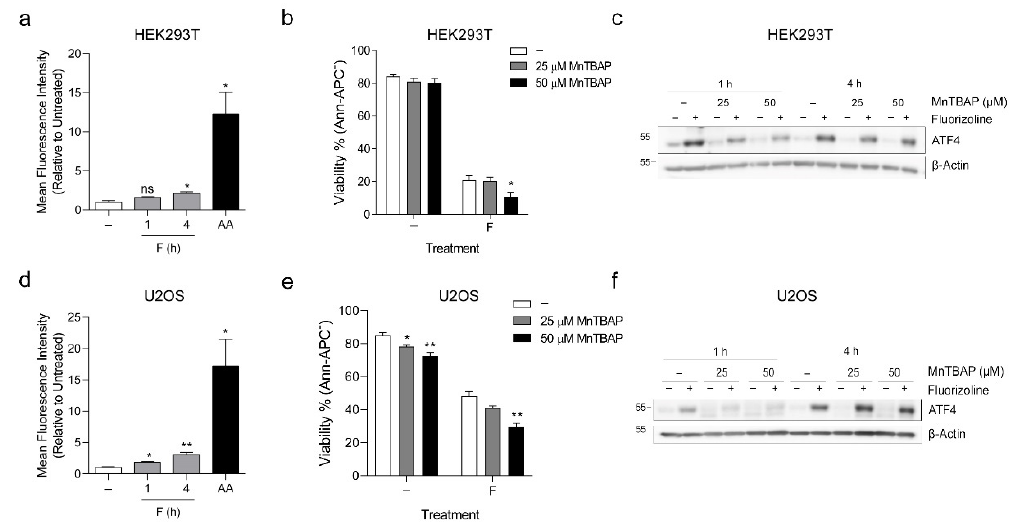
Figure 4. Fluorizoline causes a small increase in ROS production that is not required for apoptosis in HEK293T and U2OS cells. ( a ) HEK293T cells and d U2OS cells were treated with 15 or 20 µ M fluorizoline (F), respectively, or 25 and 50 µ M antimycin A (AA), respectively, for the indicated time. Cells were loaded with 5 µ M MitoSOX 15 min prior to the measurement. Superoxide production was measured by flow cytometry and is expressed as the mean fluorescence intensity. ( b , c ) HEK293T and ( e , f ) U2OS cells were pre-treated with the indicated doses of MnTBAP for 1 h and then treated with 15 or 20 µ M fluorizoline (F), respectively, for ( b , e ) 24 h or ( c ), f the indicated time. ( b , e ) Viability was measured by flow cytometry, and it is expressed as the mean ± SEM of the percentage of non-apoptotic cells (annexin V-negative). ( c , f ) Protein levels were analyzed by Western blot. β -actin was used as a loading control. These are representative images of at least three independent experiments. * p < 0.05, ** p < 0.01. ( a ) Each condition vs.-; MnTBAP vs.-( a , d n = 4; b , e ≥